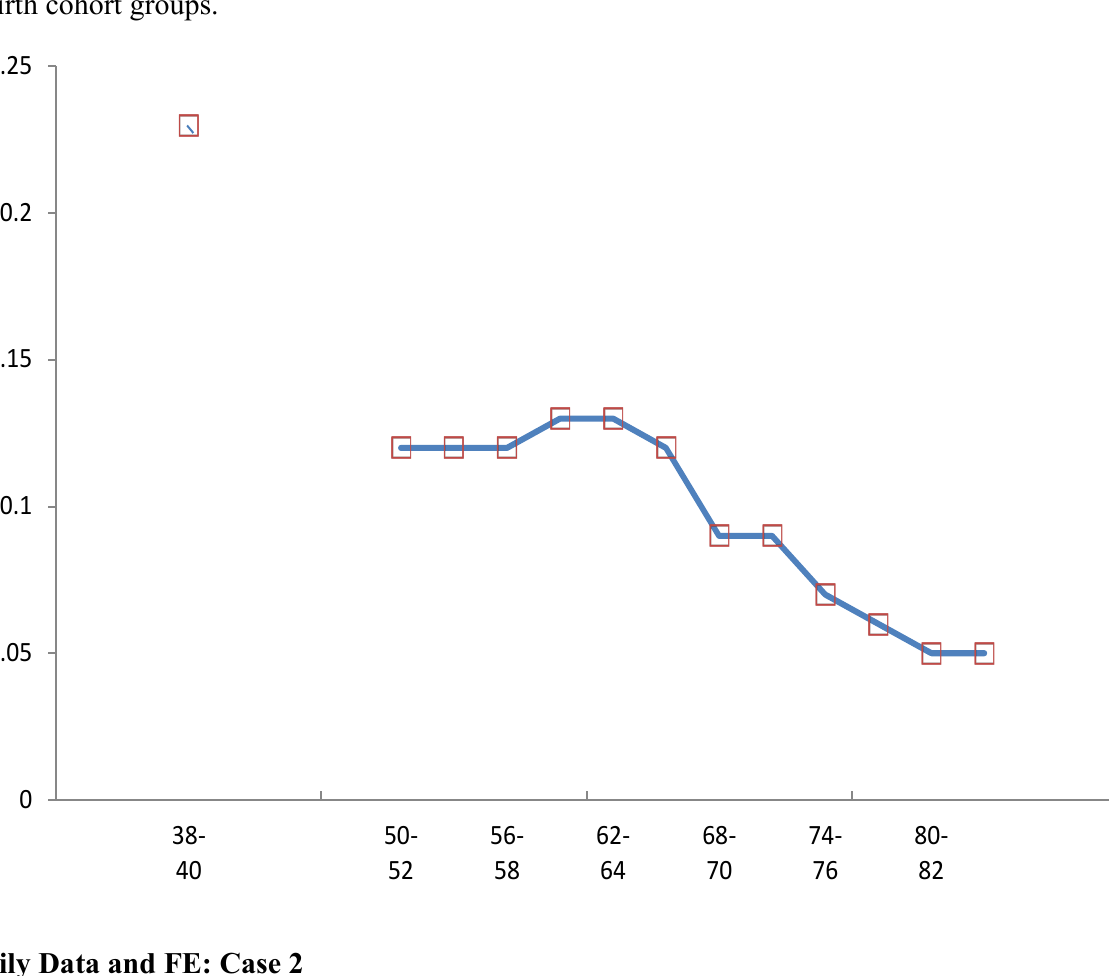
Figure 2. Correlations between conscripts intelligence test scores and sibship size across birth cohort